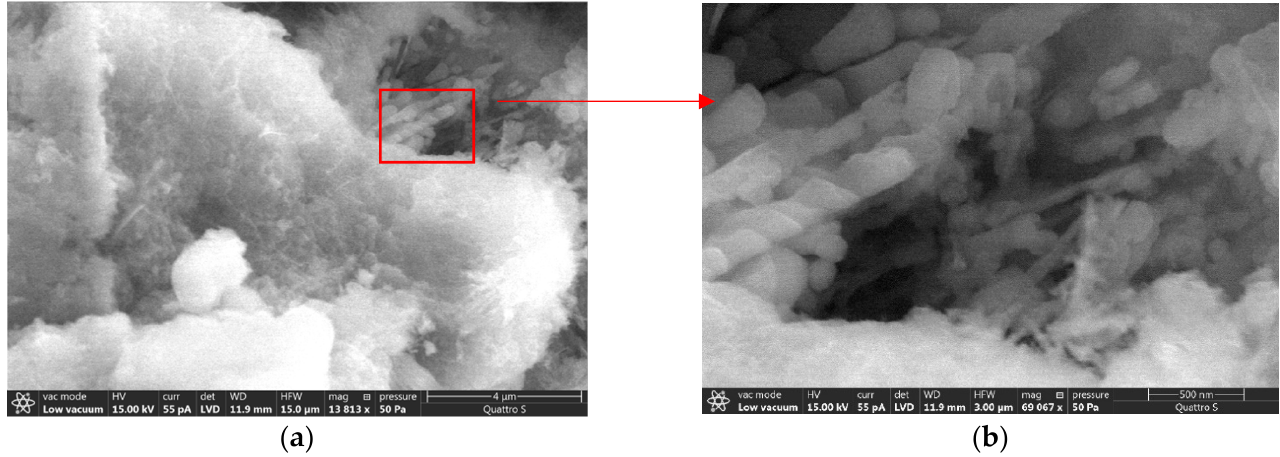
Figure 7. Microstructure of cement matrix modified with the complex additive: ( a ) at 14000-fold magnification, ( b ) at 70,000-fold magnification.